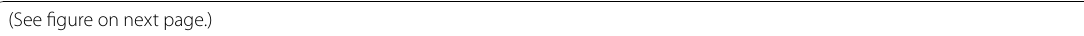
Etymology : In honor of Barry Scott recognizing his out- standing works on the genus Epichloë